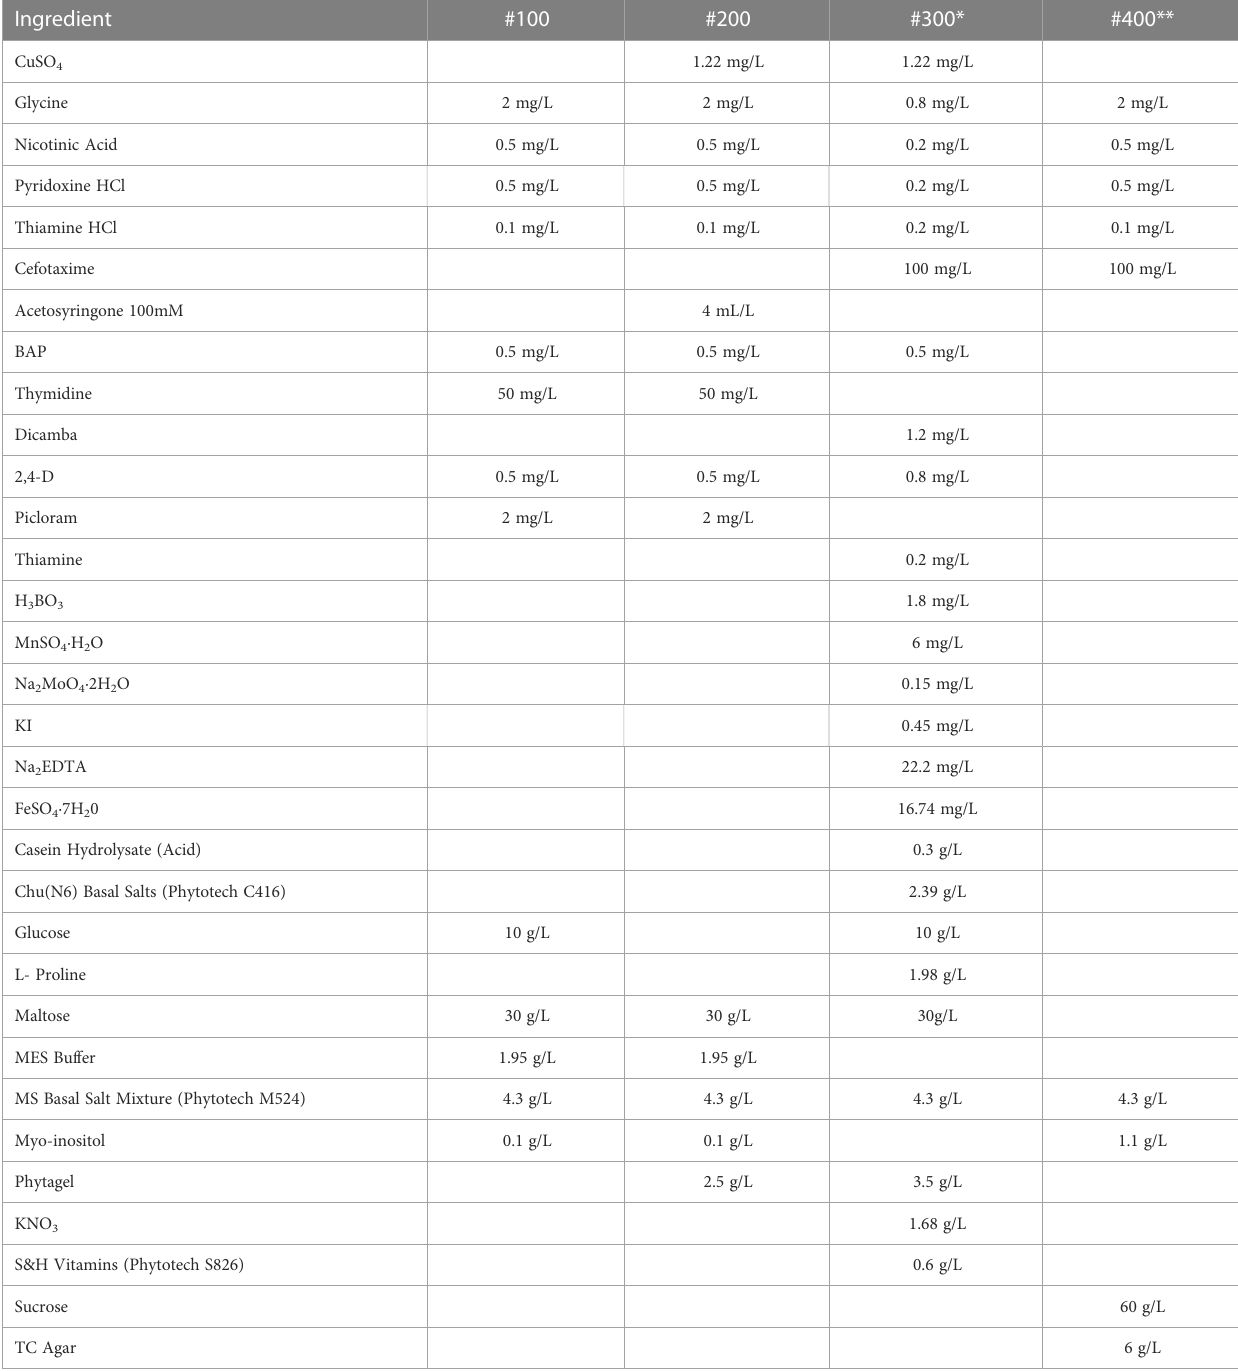
TABLE 2 Medium recipes for transformation.